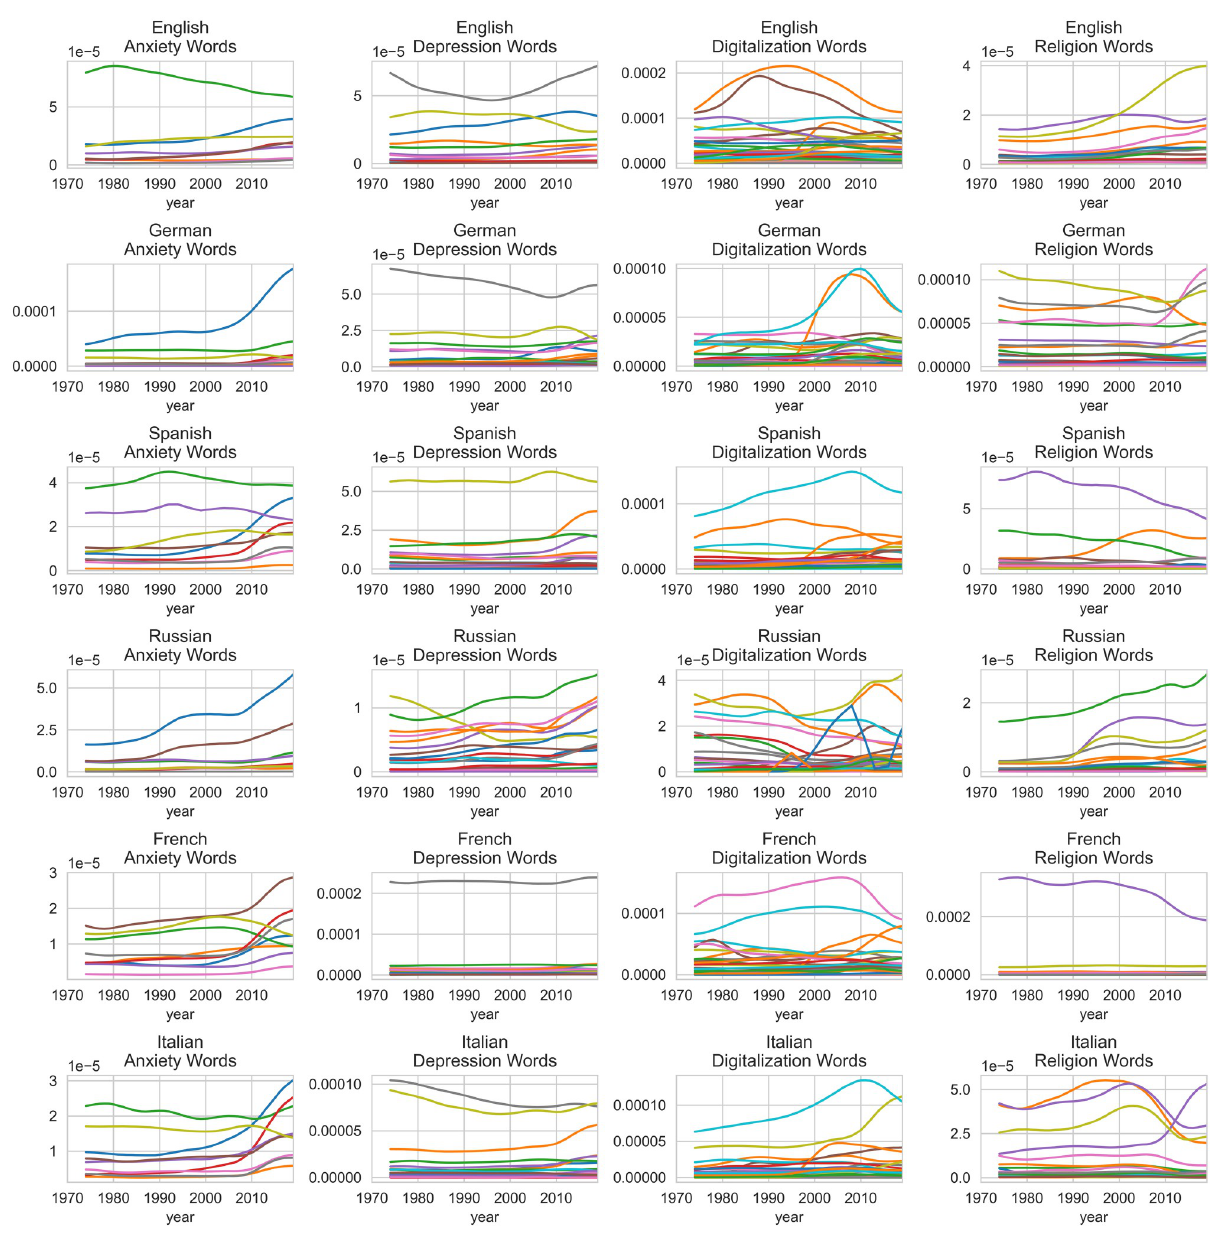
Fig 2. Rolling mean word frequencies from 1970 until 2019 for each word by each category and language, considering five years.